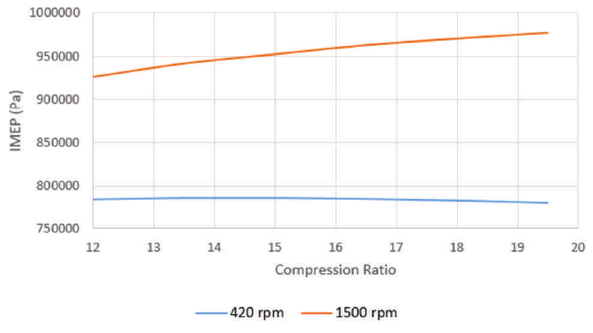
Fig. 6a. Graph of IMEP against compression